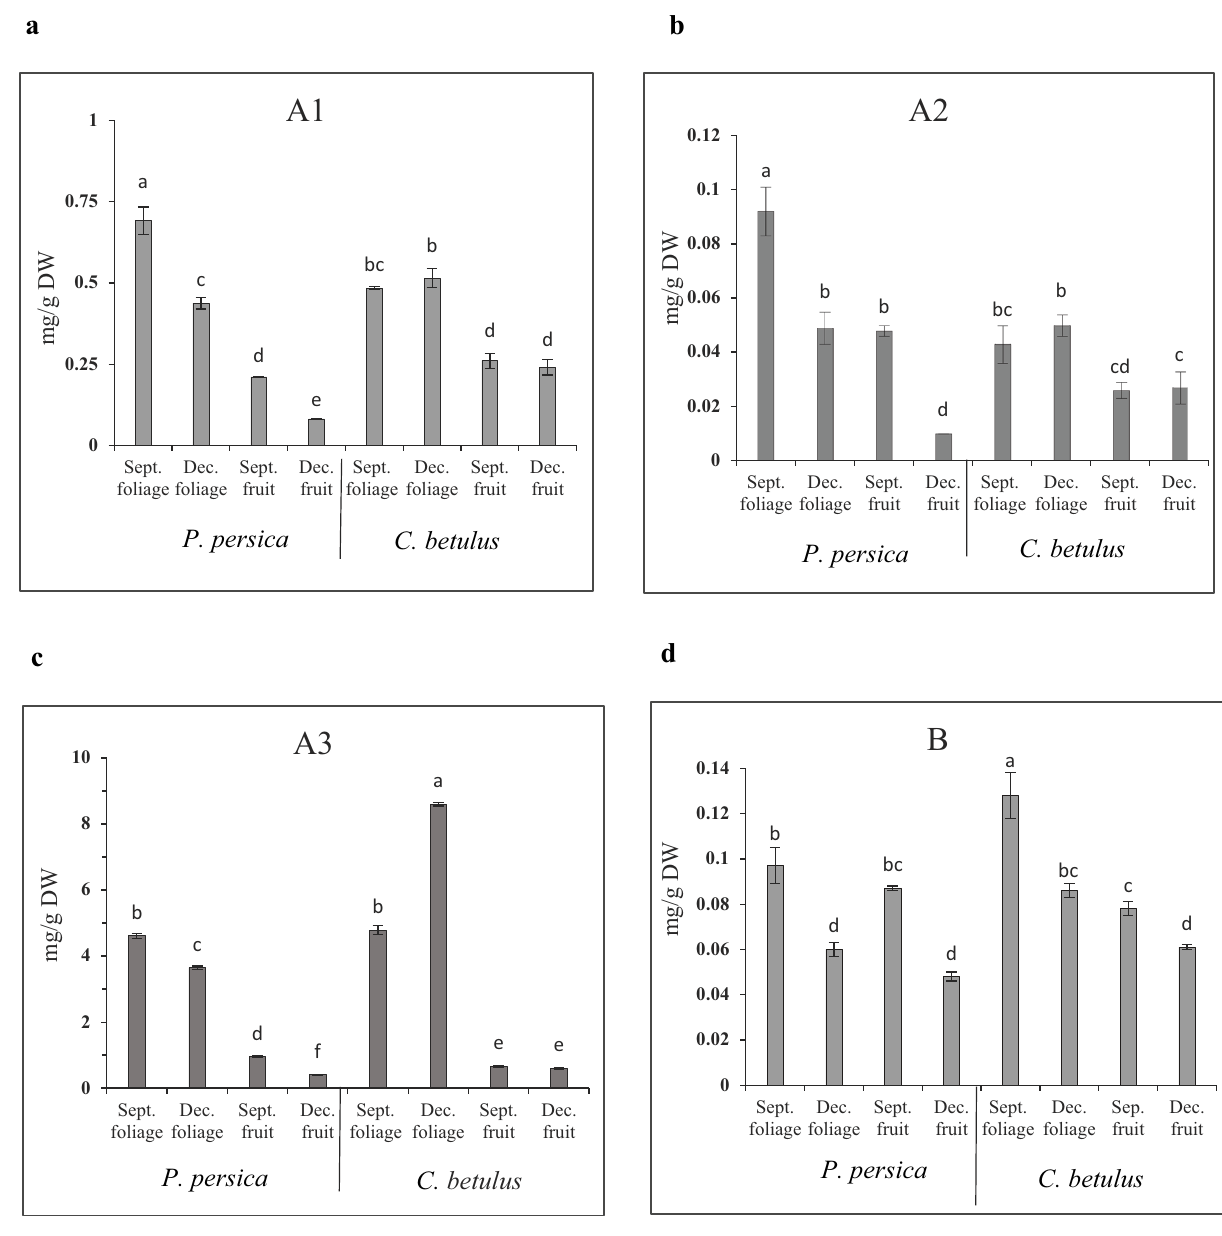
Figure 2. Viscotoxin isoforms concentrations in the foliage and fruit of V. album settled on P. persica and C. betulus at two harvest times. ( a ) Viscotoxin A1, ( b ) Viscotoxin A2, ( c ) Viscotoxin A3 and ( d ) Viscotoxin B. Each value represents the average of three replicates ± SE. Different letters indicate significant differences at P ≤ 0.01 using the least significant difference test (LSD